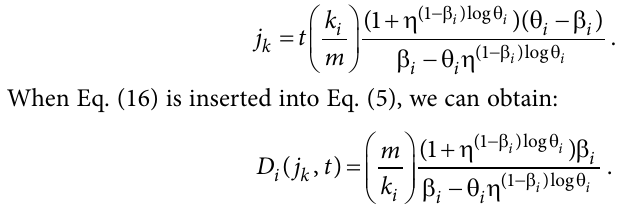
Fig. 4. The effect of the risk aversion sentiments b of credit risk contagion in the network on the infected path of node i at j = 100 and t =